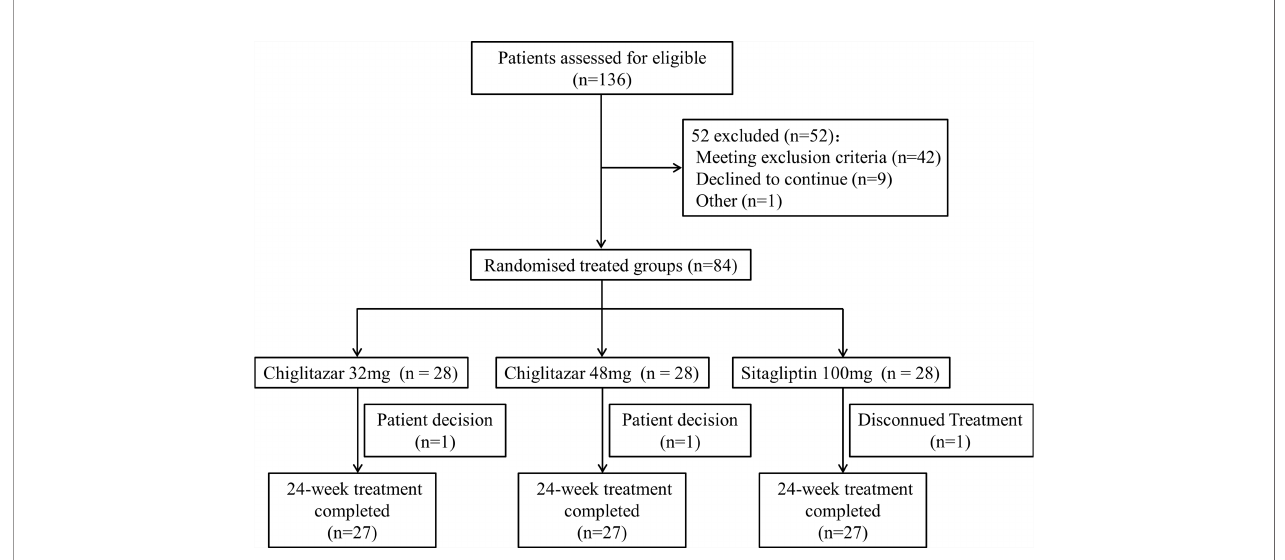
FIGURE 1 | Flowchart of the trial